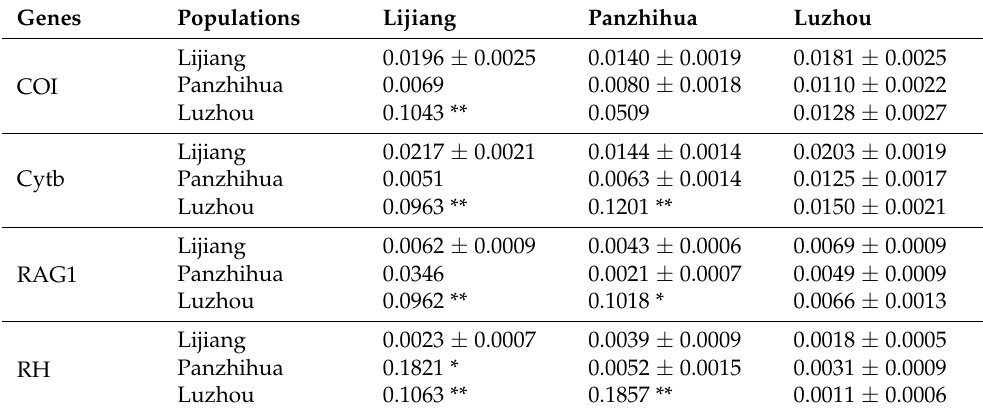
Table 2. Population pairwise F ST fixation index (below the diagonal) and mean genetic distances within (on the diagonal) and between (above the diagonal) the Jinshaia sinensis populations. *: p < 0.05; **: p < 0.01.